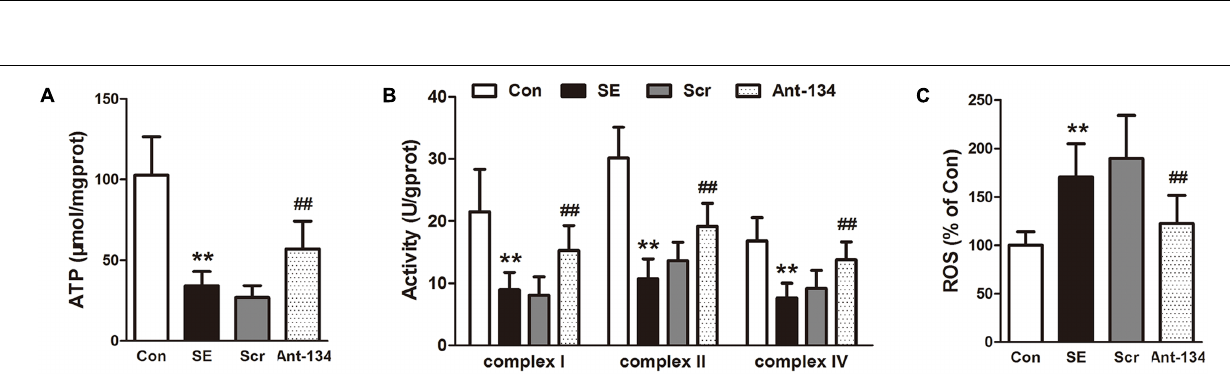
FIGURE 5 | Effects of Ant-134 on mitochondrial function in hippocampus of the SE rats. Treatment of Ant-134 enhanced (A) ATP production and (B) activities of complex I, II, and IV and decreased (C) ROS production. Data are expressed as mean ± SD, n = 6. ∗∗ p < 0.01, versus the control group, ## p < 0.01, versus the SE